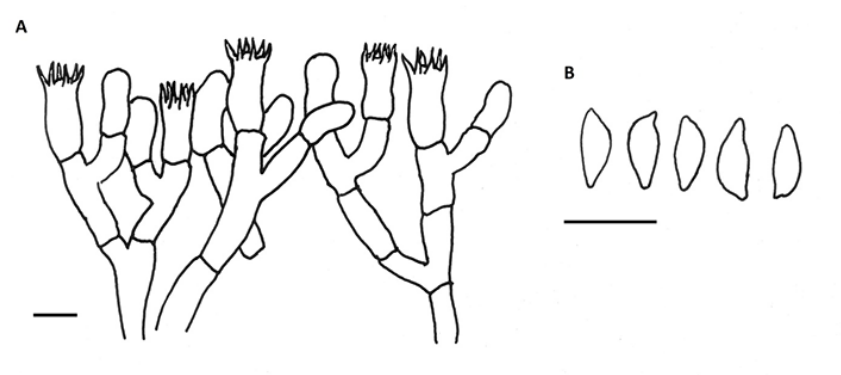
Figure 6 Microcharacters of Botryobasidium robustius Pouzar & Hol.-Jech.: ( A )